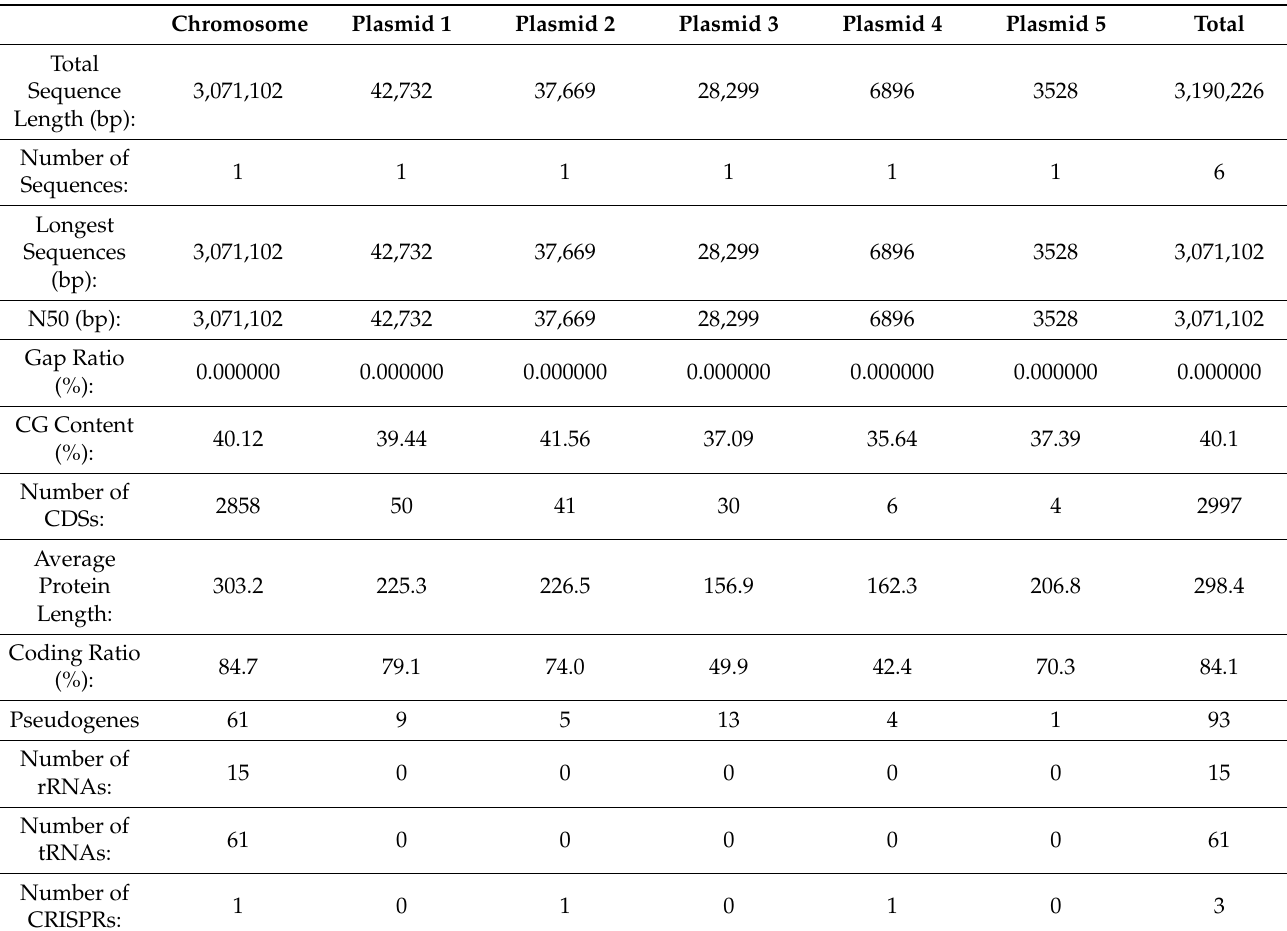
Table 1. General genome